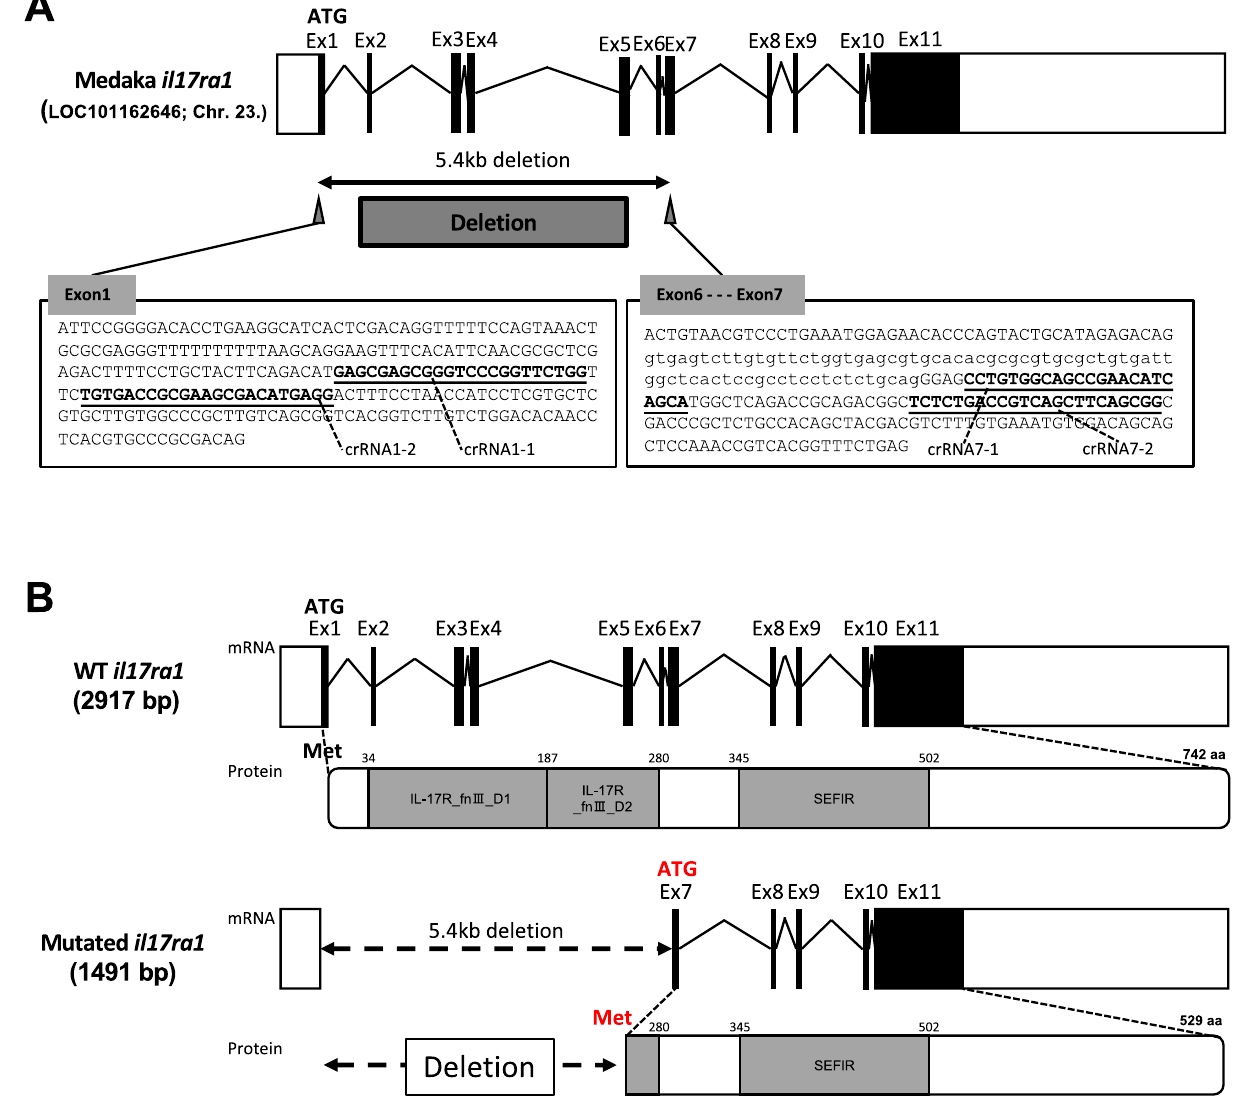
designed against exons 1–7 of the il17ra1 (5.4-kilobase deletion). ( B ) Comparison of mutated il17ra1 with the WT il17ra1 . Based on the deduced amino acid sequence, the mutated il17ra1 lacked most of the IL-17 fn III domain, which is the extracellular domain responsible for ligand binding. The domain regions were predicted using the domain-prediction tool, SMART7. The residues of the extracellular and entire intracellular regions were the same as those of WT medaka il17ra1